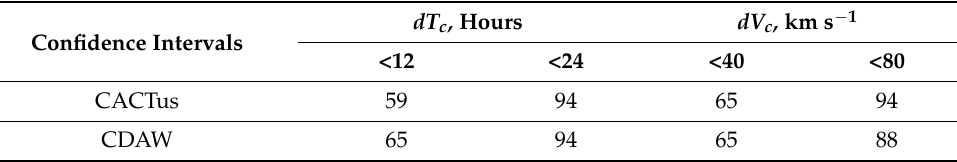
Figure 5. Probabilities of the ICME forecast obtained with the ensemble model for γ opt = 0.3 × 10 − 7 km − 1 as a function of the confidence intervals: ( a ) for the values |dT| ≤ dT c , ( b ) for |dV| ≤ dVc . The black lines correspond to the initial CACTus data, the red lines—to the CDAW data. The dashed lines show the limits of the confidence intervals according to Table 8. Table 8. Probabilities of the ICME forecast in % within the defined confidence intervals of arrival time dT c and speed dV c for the set of events of 2013–2015 obtained with the ensemble model for the CACTus and CDAW initial data and γ = 0.3 × 10 − 7 km − 1.